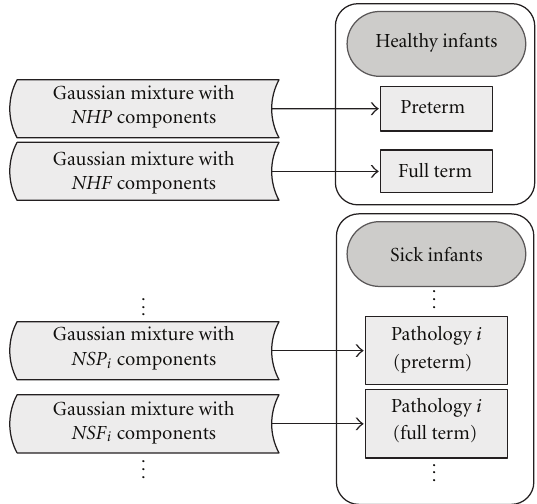
Figure 4: Mapping of estimated GMMs to pathological